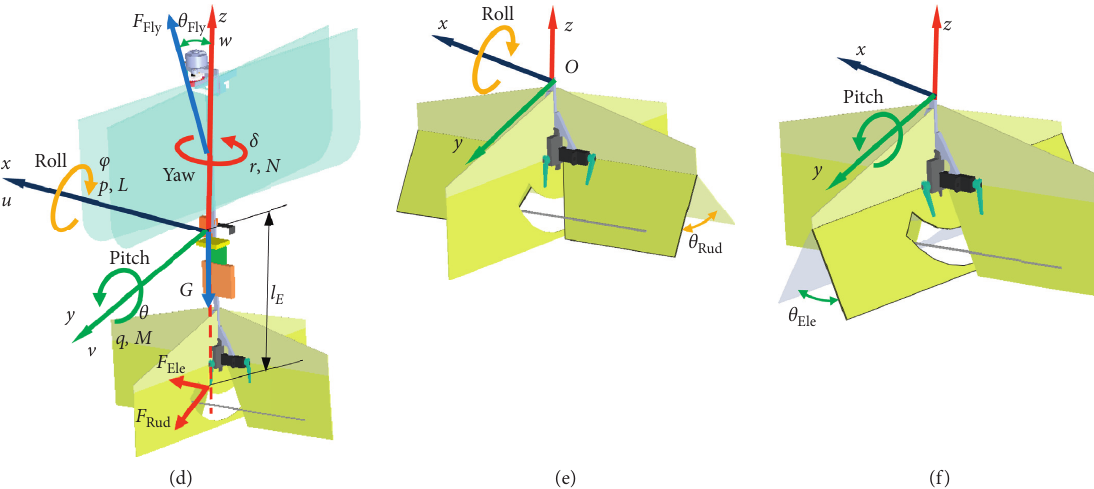
Figure 9: The positive directions of the coordinates and control mechanism: (a) dynamic analysis of T-shaped tail fin; (b) roll-control and yaw-control by moving the rudder wing; (c) pitch-control by moving the elevator wing; (d) dynamic analysis of cross-shaped tail fin; (e) roll- control by moving the rudder wing; and (f) pitch-control by moving the elevator